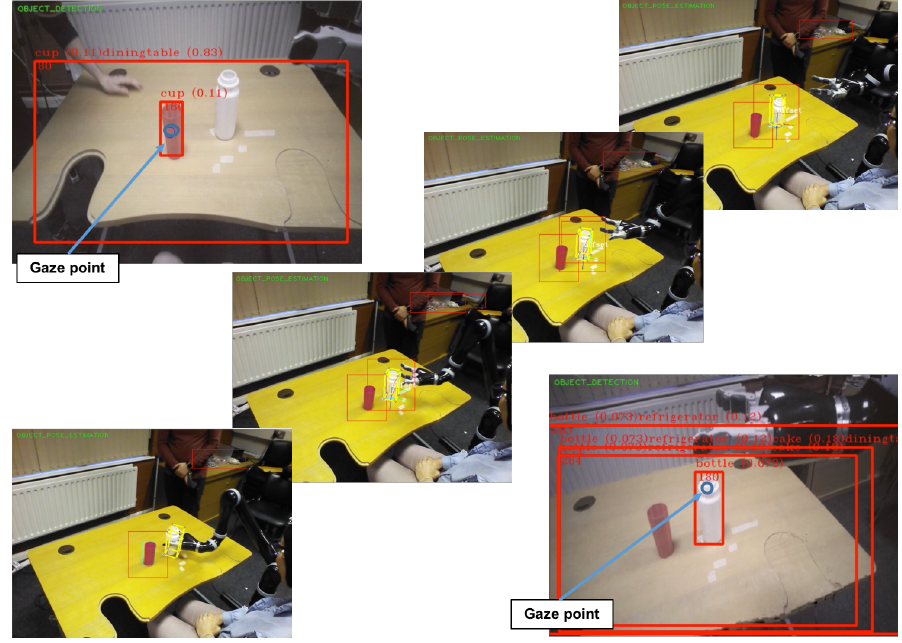
Figure 10. Images of the context recognition and eye-tracking systems in experimental tests. Examples of object detection (cup and bottle) with the estimated gaze position (blue circle). Snapshots of the experiments: grasping a bottle using the Jaco2